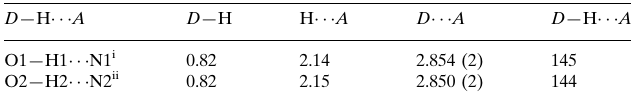
Hydrogen-bond geometry (A˚ , (cid:2)